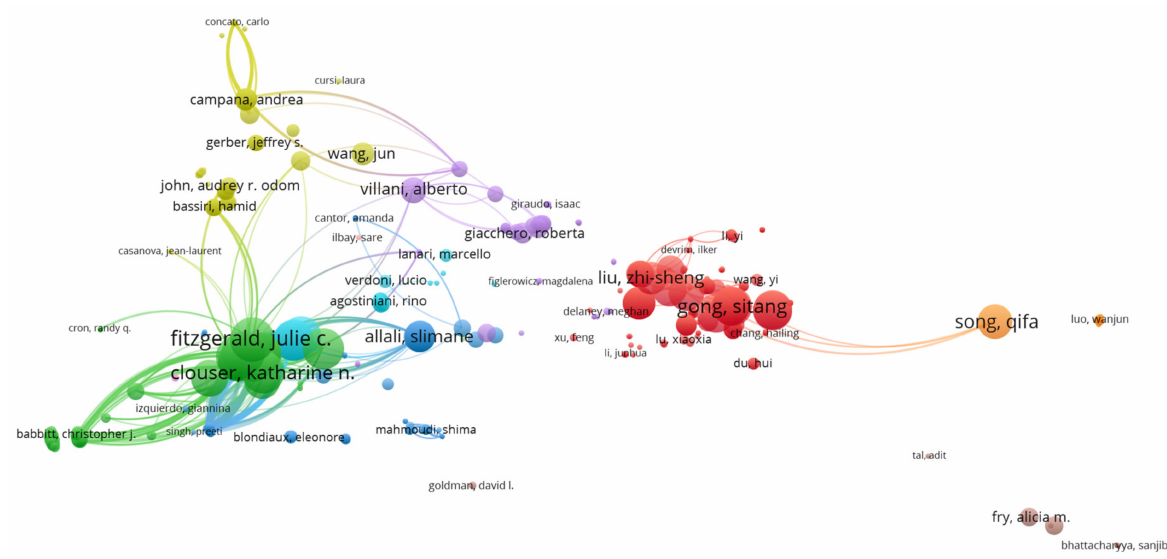
Figure 5. VOSviewer network visualization map of authors (type of analysis: citation, weights— citations, minimum number of documents of an author—2399 authors meet the threshold, largest set of connected items—396